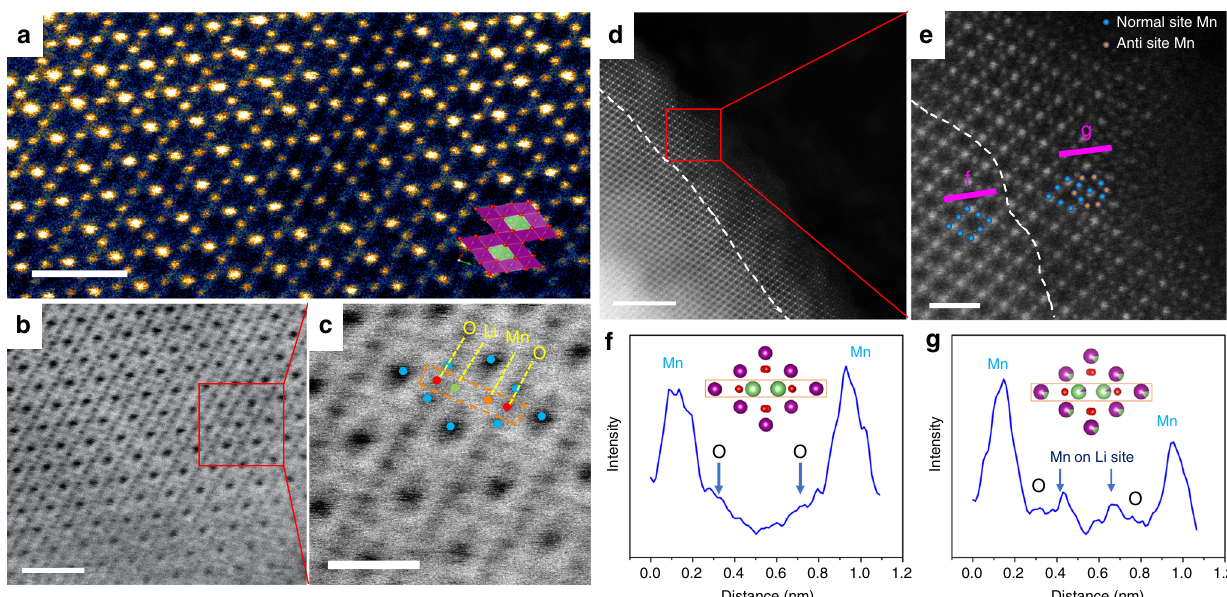
Fig. 7 Visual atomistic-level observation of detailed structure and atomic occupancy for LR-LMO bulk and surface. a The cross-sectional STEM-HAADF imaging showing the atomic structure of LR-LMO bulk. b The cross-sectional STEM-ABF imaging of LR-LMO bulk. c Enlarged image of selected panel b areas. The green, blue, red, and orange atoms represent Li, Mn, O, and anti-site Mn, respectively. d The cross-sectional STEM-HAADF imaging showing the atomic structure of the LR-LMO surface. e Enlarged image of selected panel d areas. The blue and orange atoms represent normal Mn atom and anti- site Mn atom. f , g Corresponding atomic contrast curve of purple-bar f and purple-bar g labeled in panel e . Scale bars, 1 nm ( a , b ); 0.5 nm ( c ); 5 nm ( d ); and 1 nm ( e